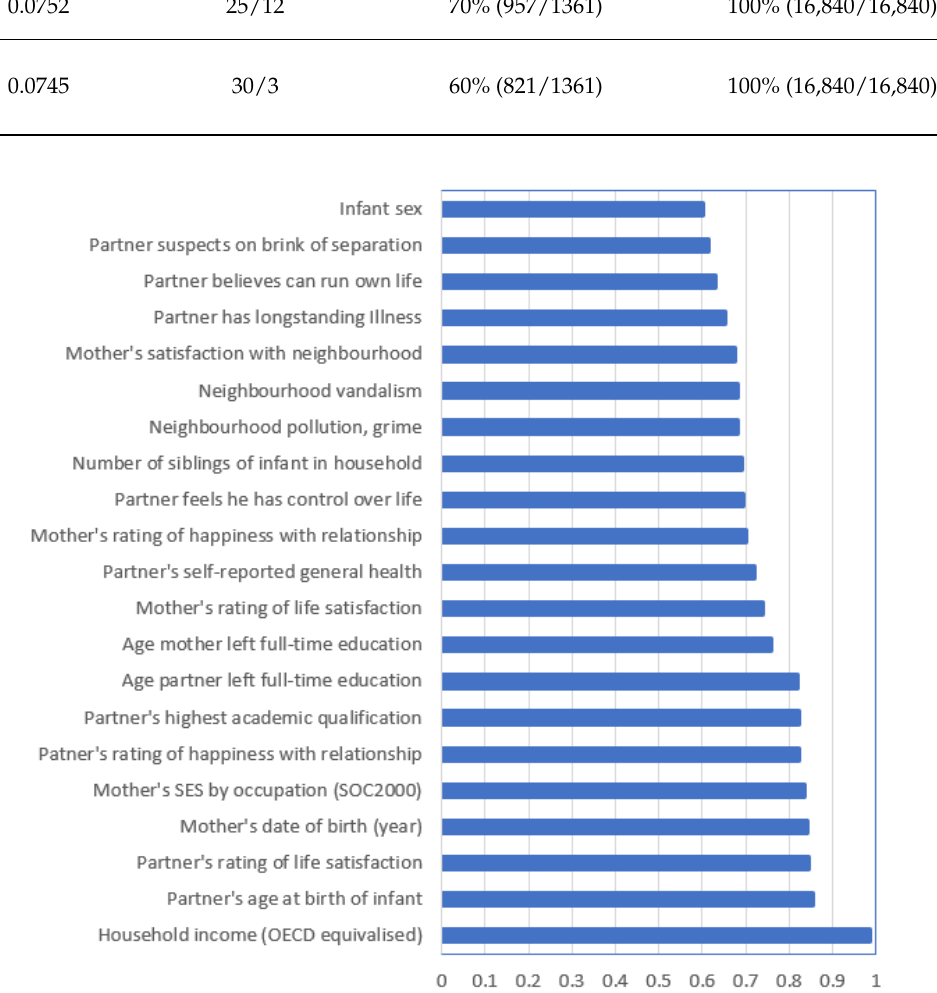
Figure 1. Importance scores for features with average importance scores above 0.6 in 72-feature RF algorithms predicting very premature birth before 32 weeks.